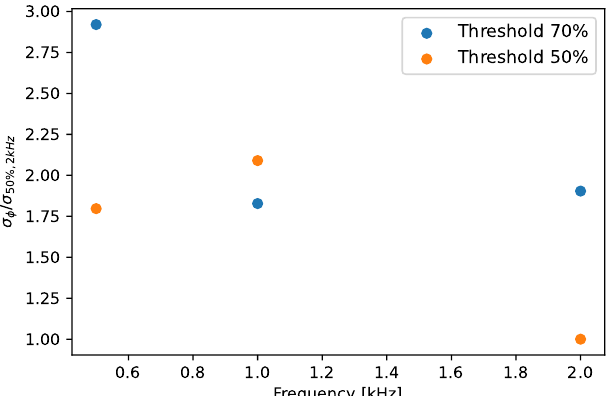
Figure 5. Time shift analysis: uncertainty introduced by the acquisition system due to wave frequency content and threshold